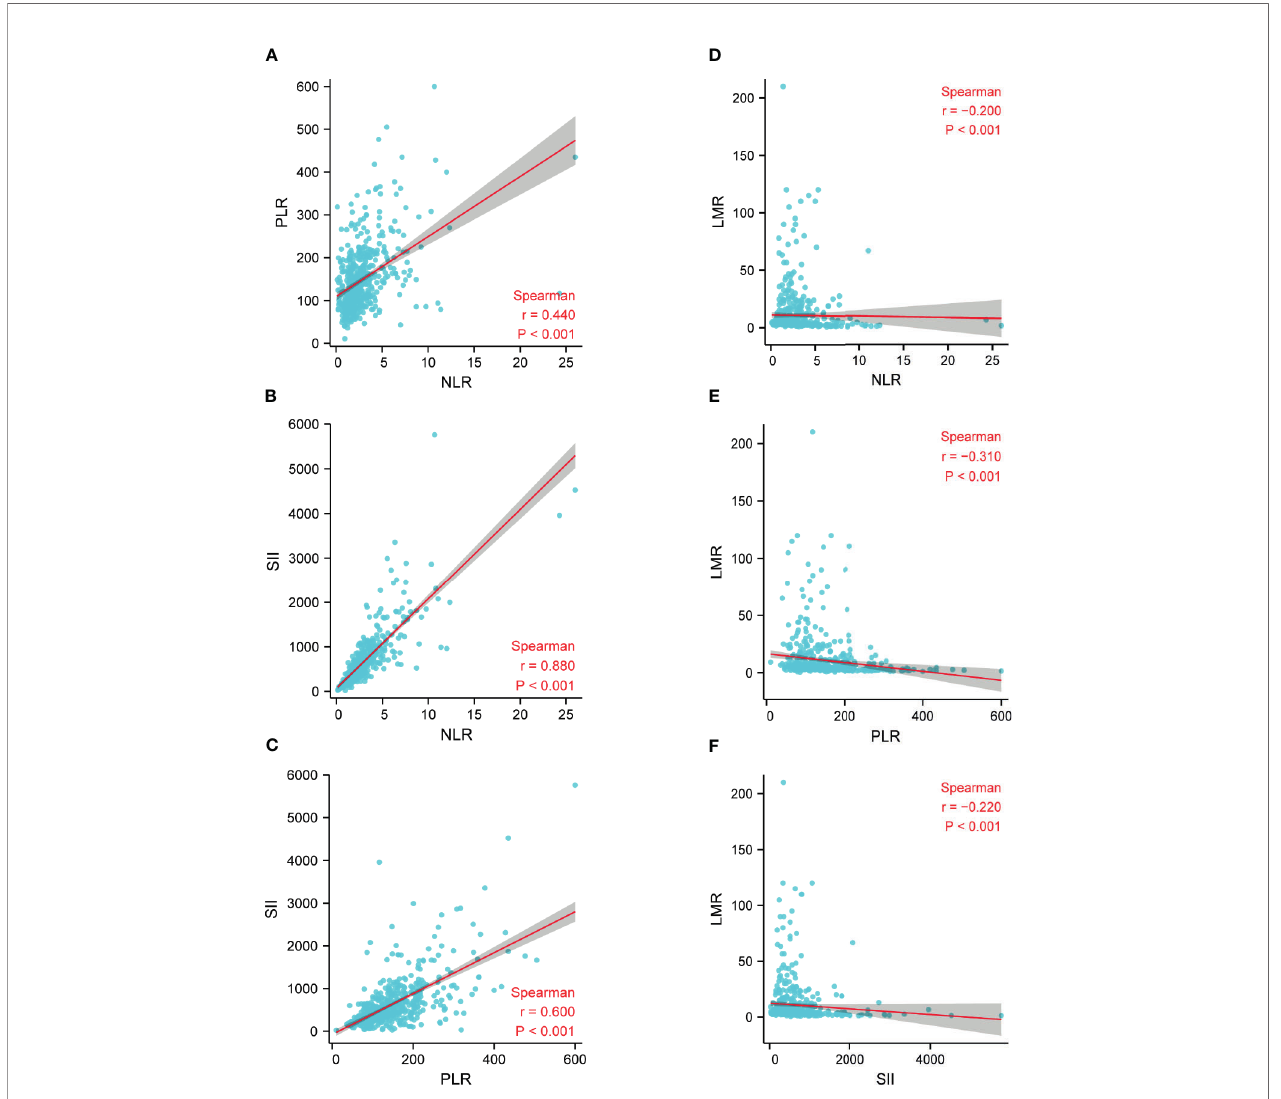
FIGURE 3 | Correlation between LMR, NLR, PLR, and SII in the whole study population. (A) The correlation between NLR and PLR; (B) The correlation between NLR and SII; (C) The correlation between PLR and SII; (D) The correlation between NLR and LMR; (E) The correlation between PLR and LMR; (F) The correlation between SII and LMR. LMR, lymphocytes-monocytes ratio; NLR, neutrophils-lymphocyte ratio; PLR, platelets-lymphocytes ratio; SII, systemic immune-in fl ammation index; r,